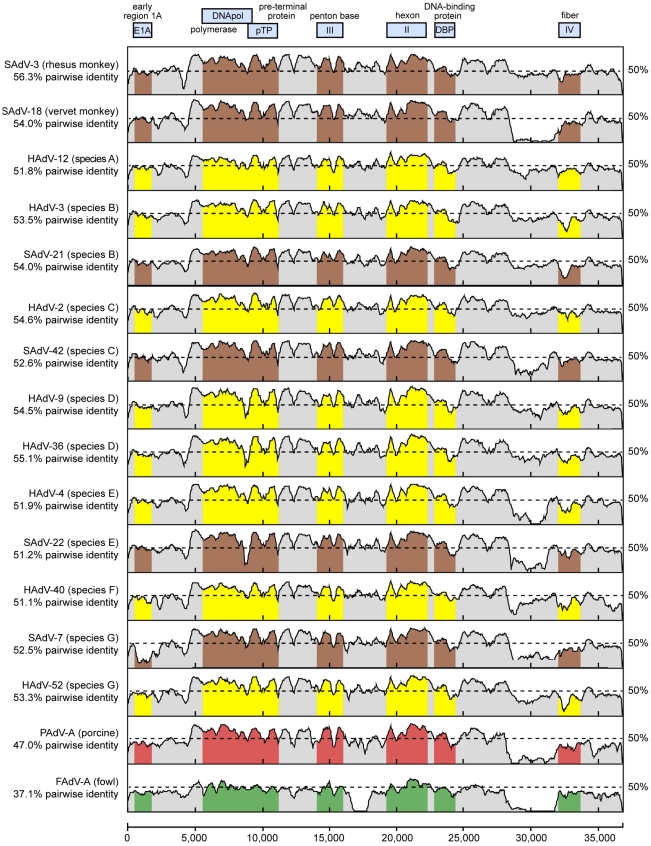
Scanning pairwise alignment of representative adenoviruses with TMAdV.The scanning nucleotide pairwise identities of TMAdV relative to representative human (yellow) or simian (brown) adenoviruses in species A–G, porcine adenovirus (red), and fowl adenovirus (green) are shown. The window size is 400 bp with a step size of 40 bp. The x-axis refers to the nucleotide position along the ∼37 k genome of TMAdV. Abbreviations: HAdV, human adenovirus; SAdV, simian adenovirus; PAdV, porcine adenovirus; FAdV, fowl adenovirus.